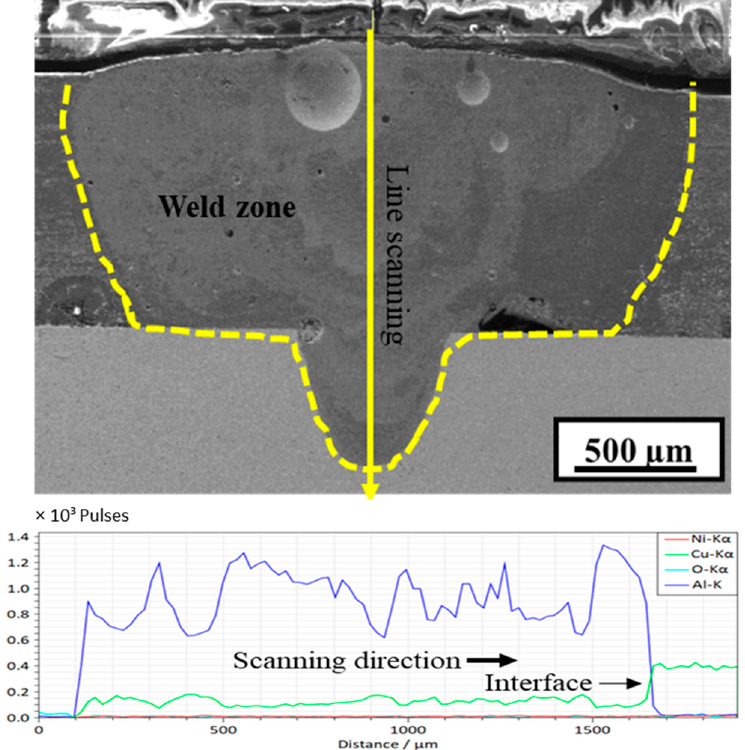
Figure 11. SEM/EDS vertical line scan of sample A4 (power = 1500 W, welding speed = 30 mm/s).